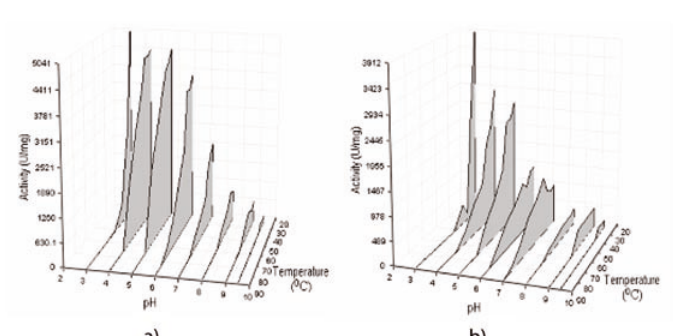
Figure 4. Activities of purified HRP (a) and HRP-dextran aldehyde conjugate (b) with molar ratio n temperatures. Activities were determined with 60 minutes incubation at working temperatures.